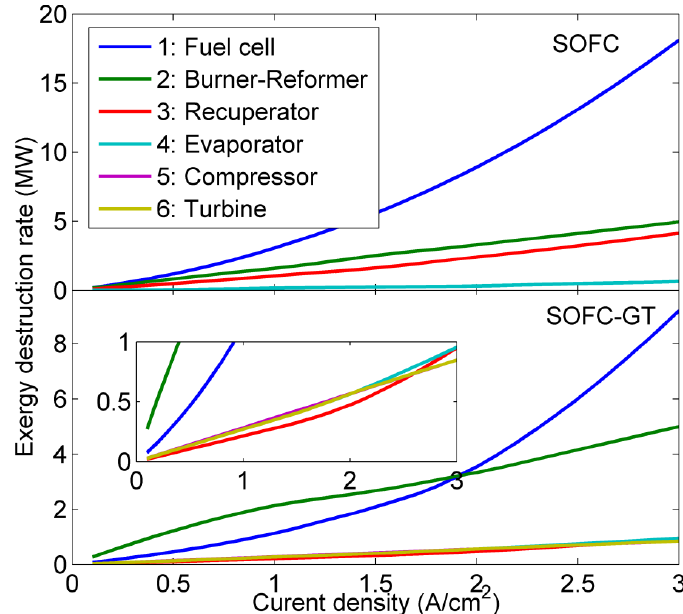
Figure 9. Exergy destruction of SOFC-GT’s and SOFC’s devices; T